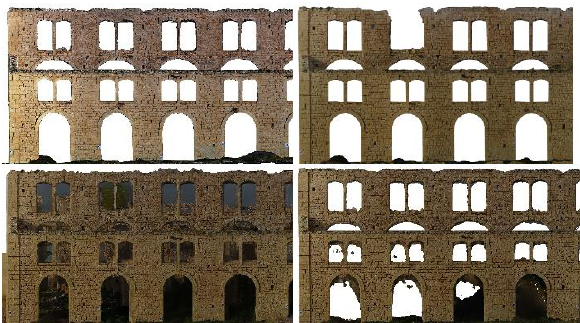
Figure 21. Comparison among different elevations from images: from us (a), from SBM2017 participants (b, c,